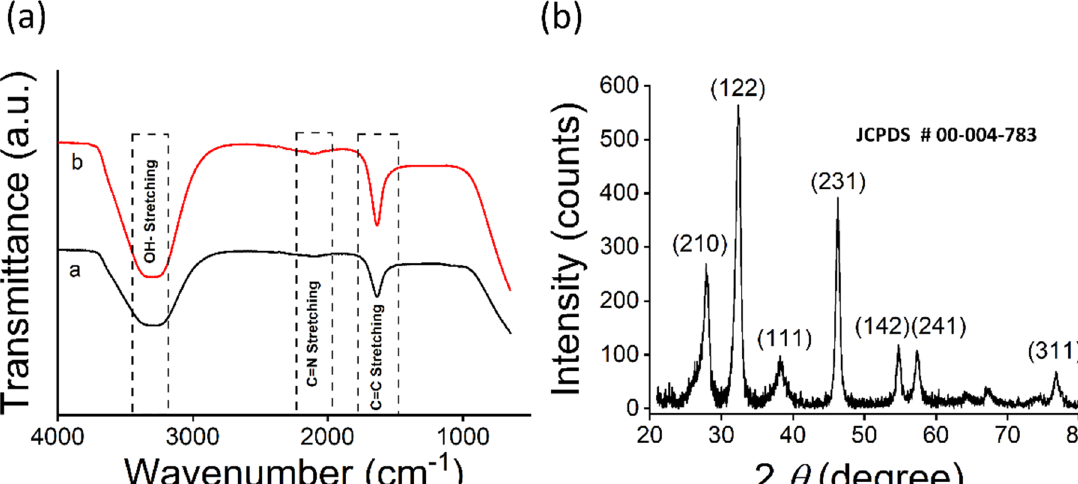
Figure 3. FTIR and XRD analysis. ( a ) The possible head groups of SPE phytochemicals involved in the bio reduction of SN are shown by FTIR analysis for SPE (black curve) and SL-SpNPs (red curve). ( b ) P-XRD results demonstrating the 2 θ values confirming the lattice structure of